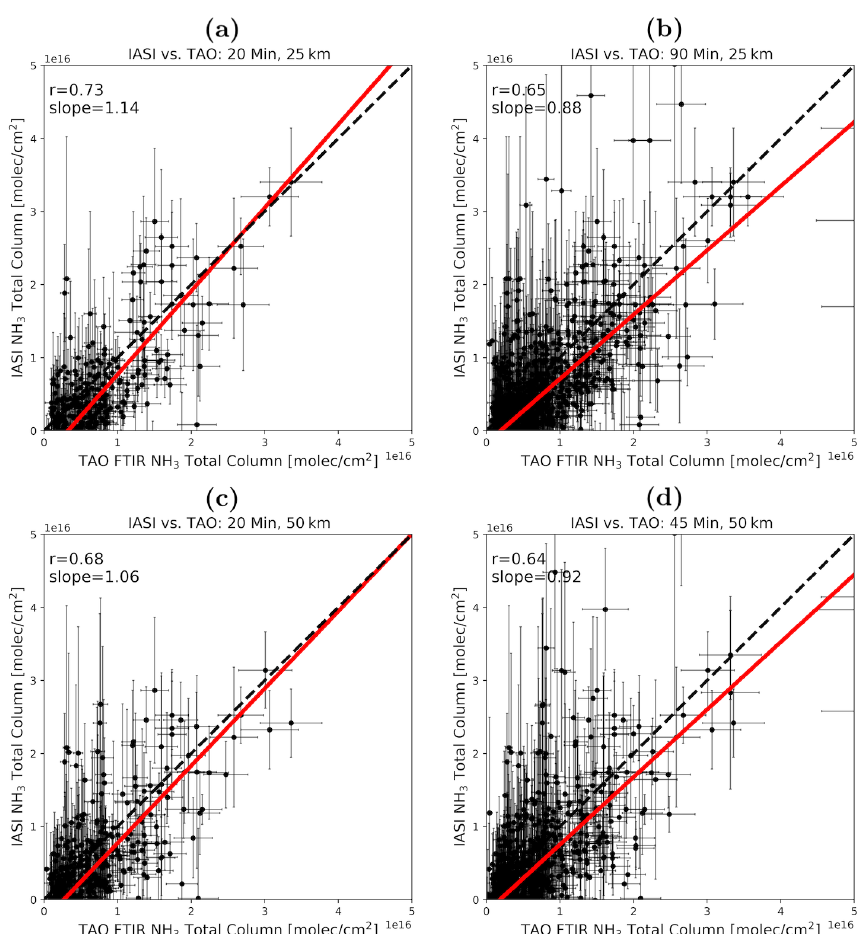
Figure 7. Correlation plots for IASI vs. TAO FTIR NH 3 total columns, with coincidence criteria of (a) 20min and 25km, (b) 90min and 25km, (c) 20min and 50km, and (d) 45min and 50km. Data from 2008 to 2018 are plotted. Dashed lines indicate slope = 1, while the red lines are the lines of best fit. Error bars are the reported observational